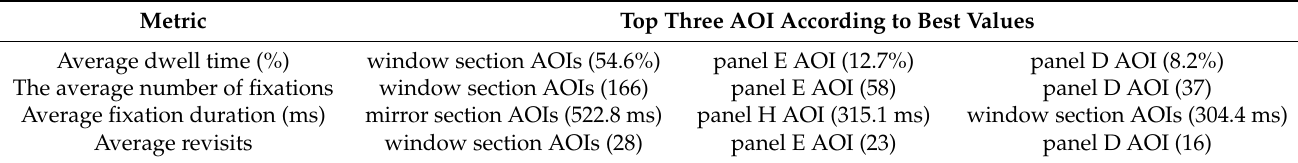
Table 6. The arrival procedure’s average statistic for train station Bytˇca.